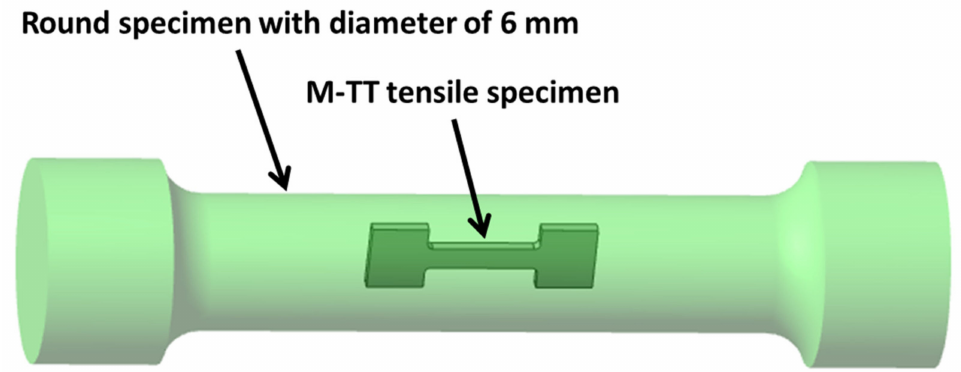
Figure 4. Schematic illustration of M-TT flat sample excised from the 6 mm diameter round